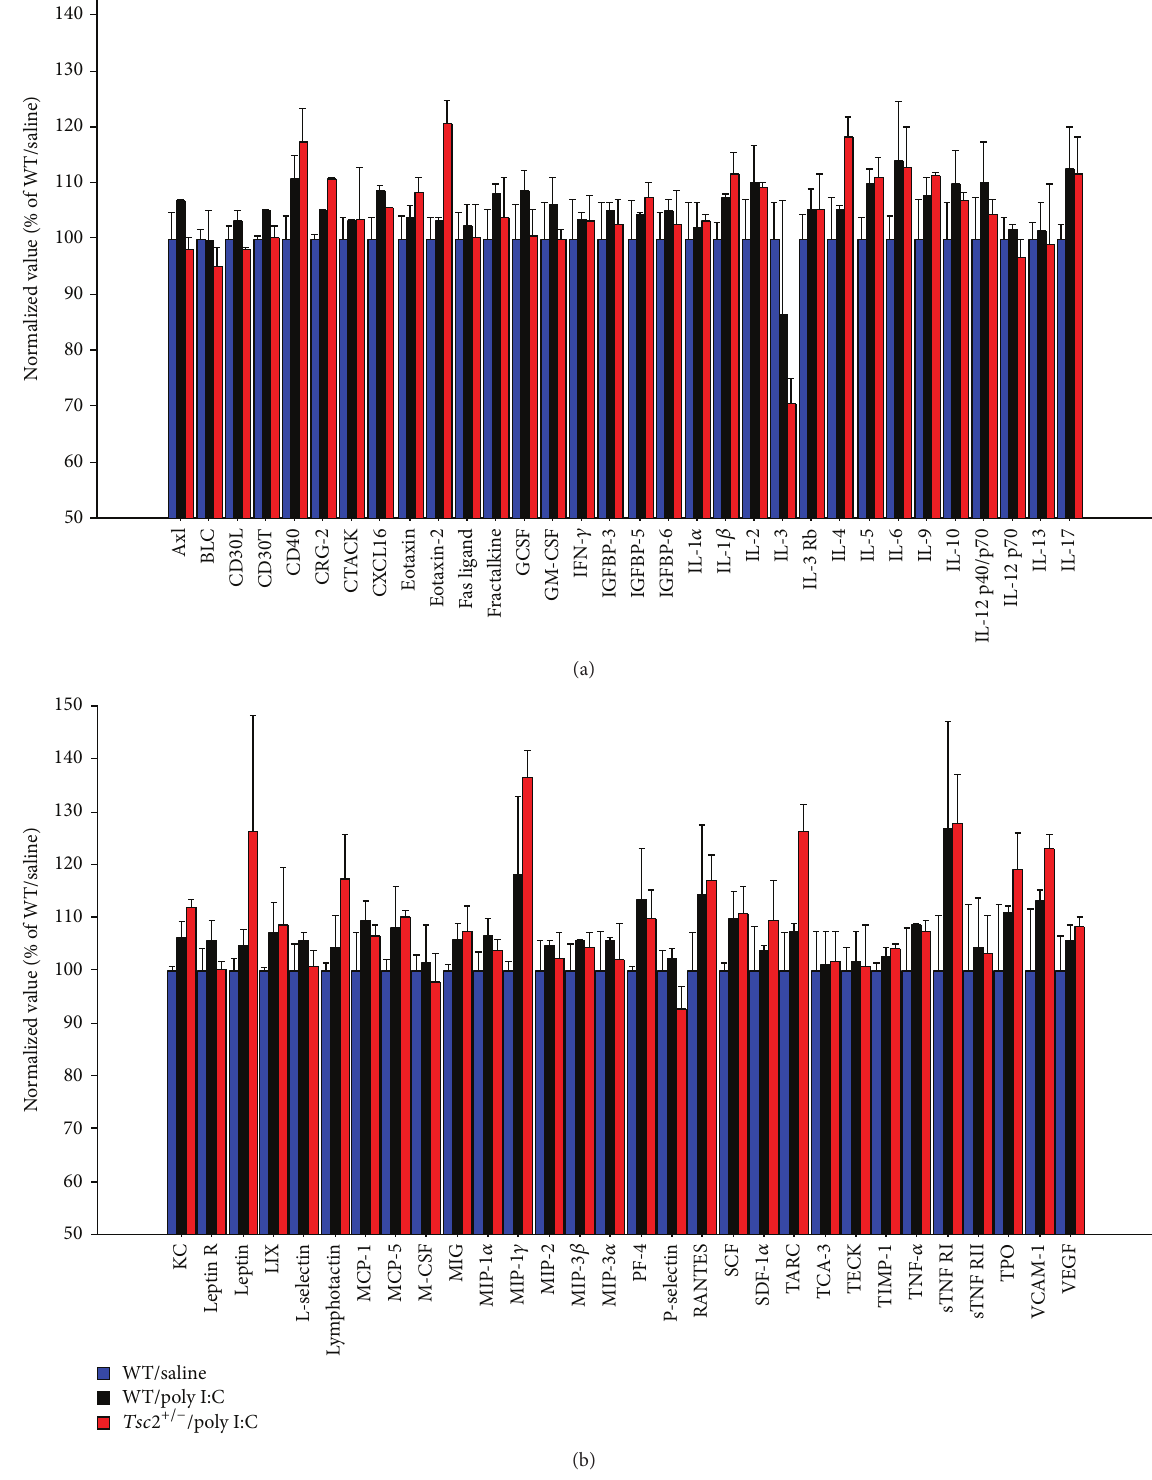
Figure 3: (a) and (b) This graph shows relative cytokine abundances as measured by cytokine antibody arrays in fetal brain at 6.5 h after gestational poly I:C. Shown are means +/ −